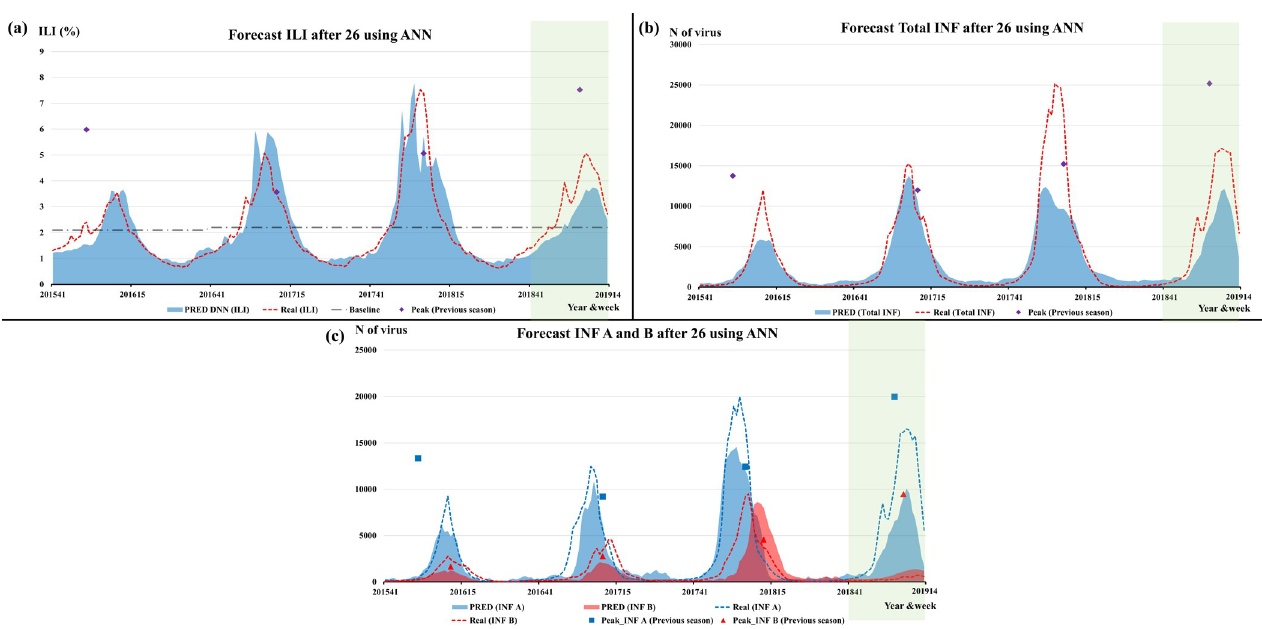
Fig 6. The prediction of ANN for ILI (a) and Total influenza (b), influenza A and influenza B viruses (c) after 26 weeks from 2015 to 2019 in the